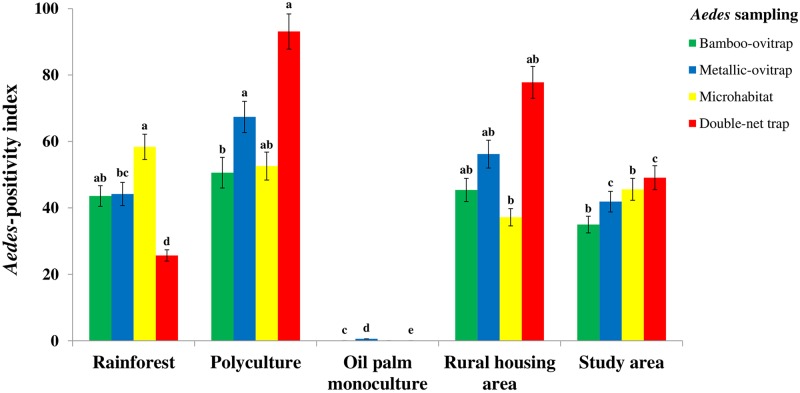
Aedes mosquito species occurrence among the macrohabitats in oil in oil palm-dominated landscapes in southeastern Côte d’Ivoire from January to December 2014.Error bars represent the standard error (SE). Letters indicate the results of the GLMM. Groups that do not share the same letter for the same sampling method are significantly different.